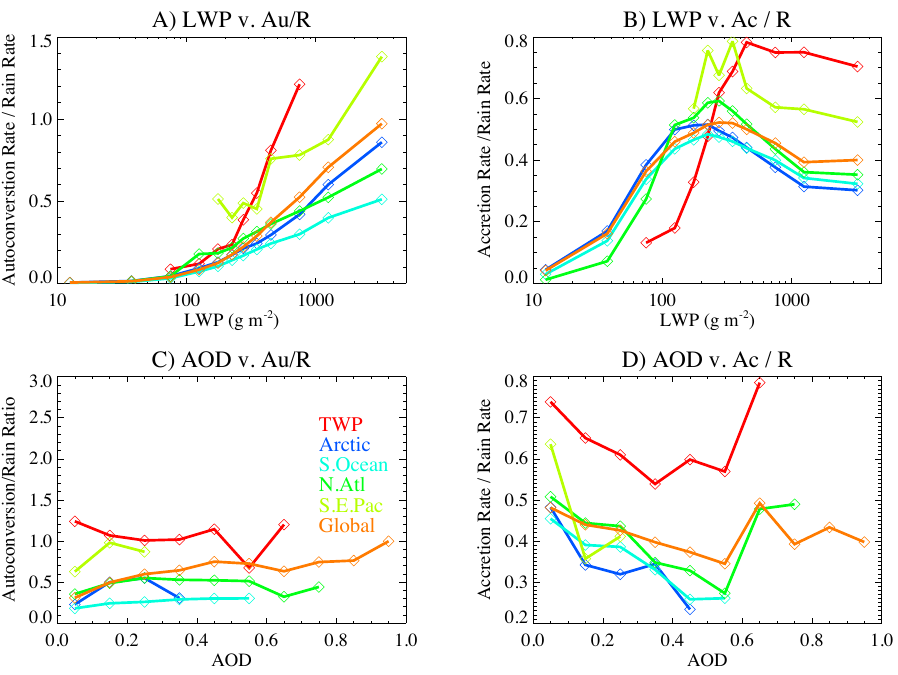
Fig. 6. Regional averages of the ratio of (A, C) autoconversion and (B, D) accretion to surface precipitation rate for different regions (colors, see Fig. 5 for description) binned by (A, B) LWP and (C, D) AOD.